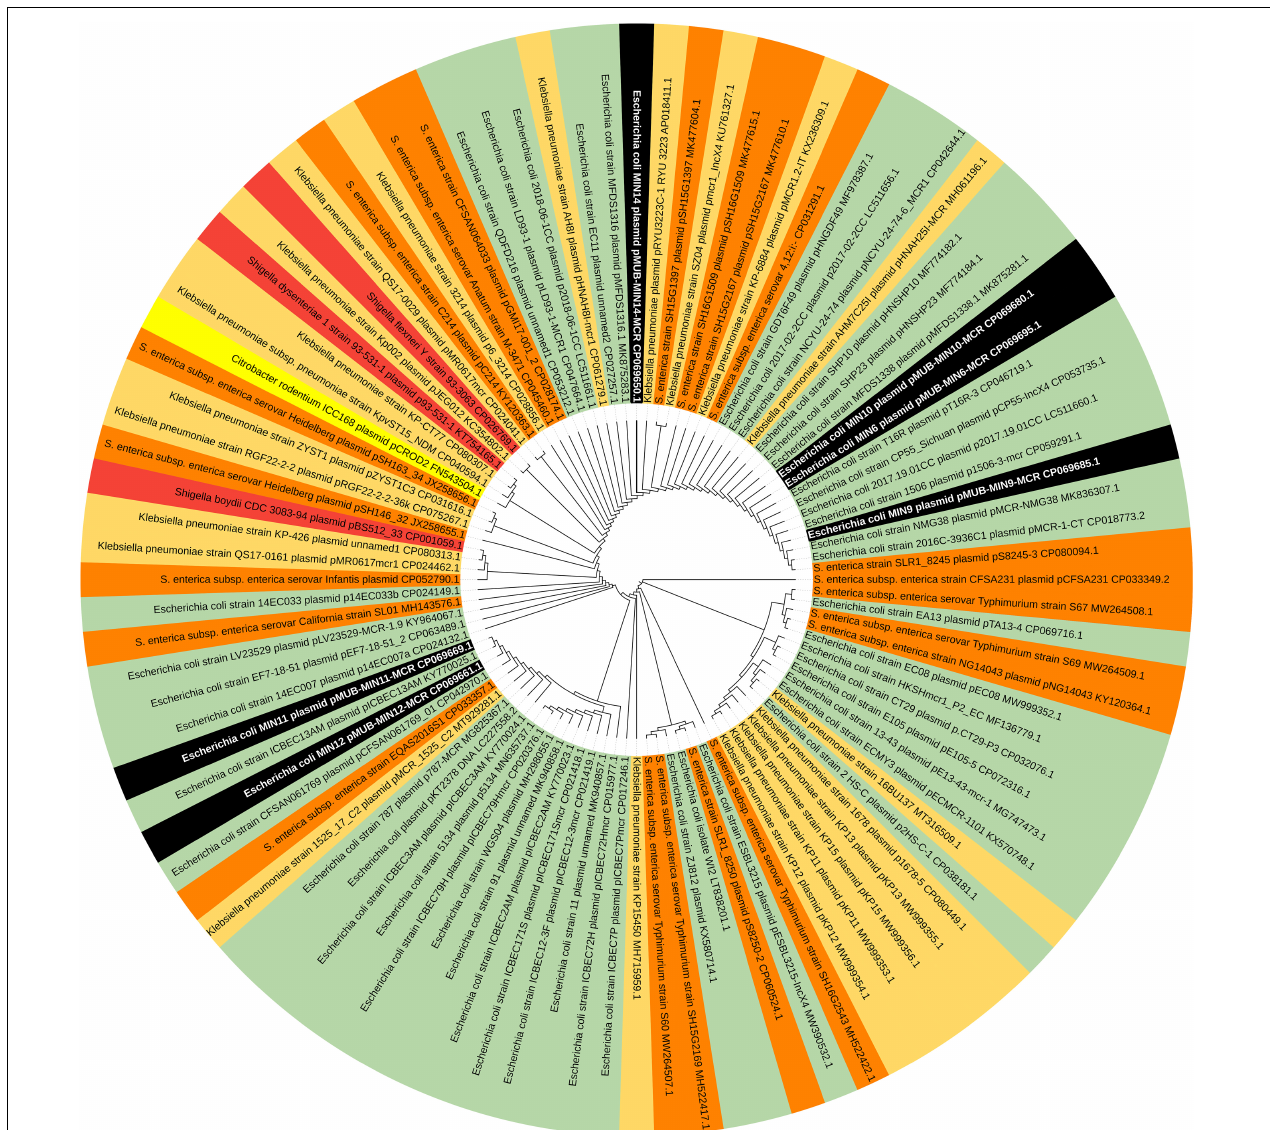
FIGURE 3 | Phylogenomics of IncX4 plasmids bearing mobile pEtN transferase-encoding genes. Colored segments represents bacterial genera harboring IncX4 plasmids – black segments – E. coli strains MIN6, MIN9, MIN10, MIN11,MIN12, MIN14; green segments – E. coli; light orange segments – K. pneumoniae; orange segments – Salmonella spp.; red segments – Shigella spp., yellow segments – Citrobacter